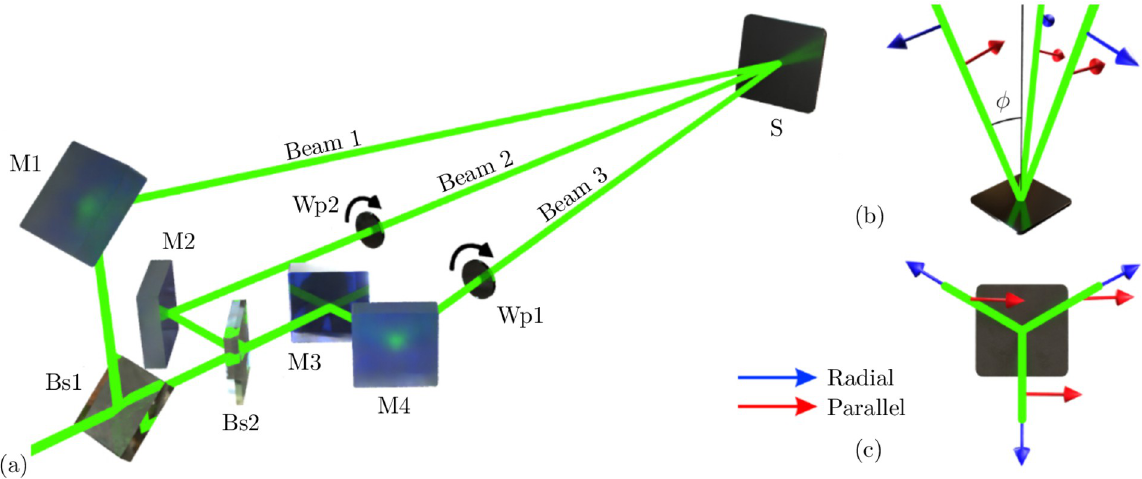
Fig 1. (a) Schematic representation of the optical setup used in the experiments. Bs1: beamsplitter 30:70; Bs2: beamsplitter 50:50; M1–M4: mirrors; Wp1, Wp2: half-wave plates; (b) Side and (c) top view of the distribution of three split beams on the sample surface. The blue and red arrows represent the polarization vectors in the case of radial and parallel distribution,